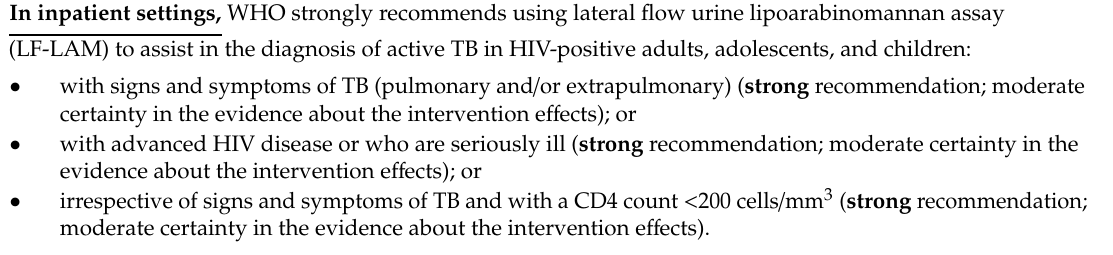
Table 2. Updated 2019 WHO guidelines for the use of AlereLAM